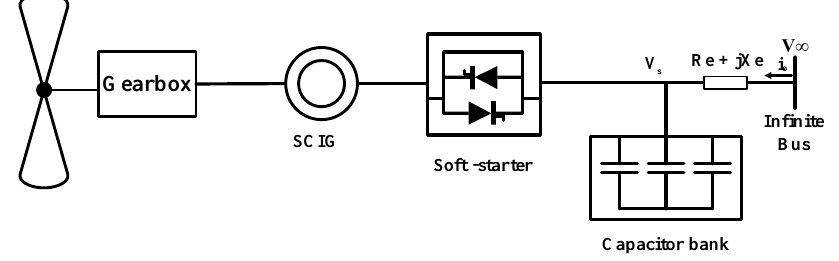
Figure 10. Fixed-speed wind turbine (FSWT) attached to the infinite bus.